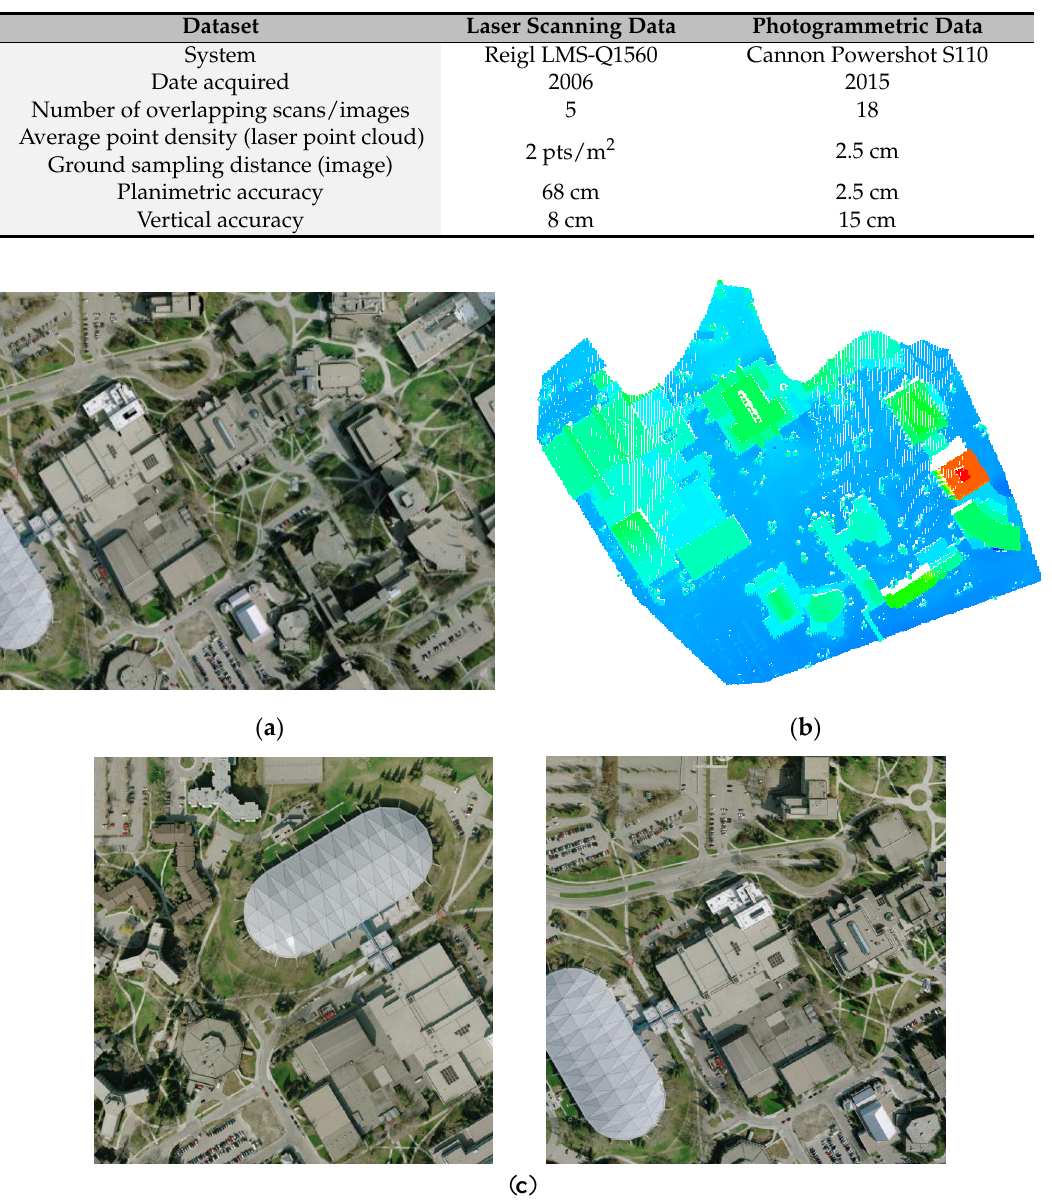
Table 1. A summary of the laser scanning point cloud and imagery characteristics utilized in the first experimental dataset.